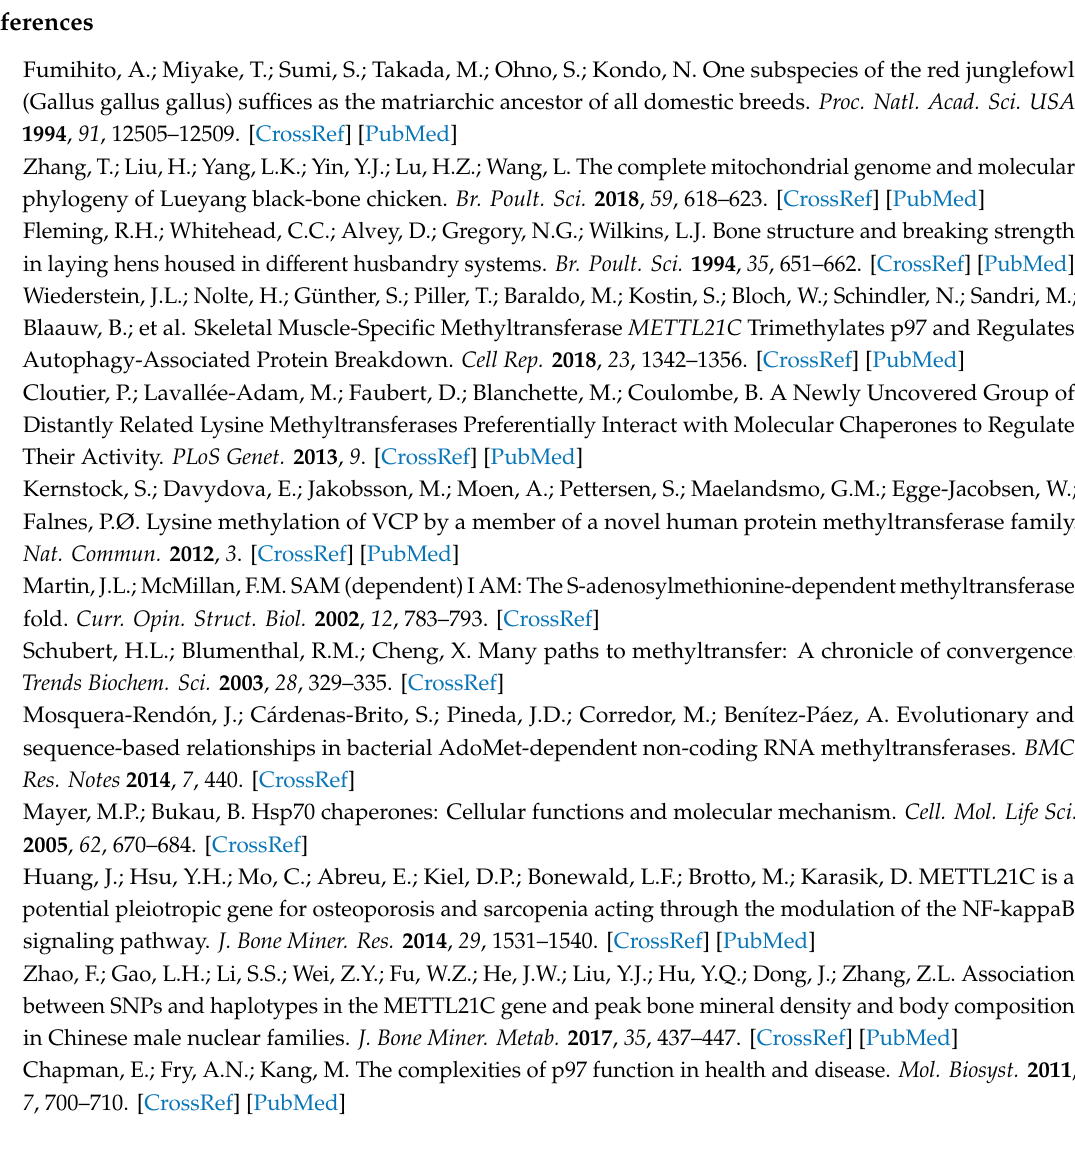
Figure S1: Conserved domain of the METTL21C family identified in 10 chickens ( G. gallus ). Table S1: A total of six samples of chicken muscles used for expression profiling in this study. Table S2: Primer information of qPCR. Table S3: The distribution numbers of METTL21C genes in Groups I–VI. Table S4: Expression data of METTL21C genes in flowers at di ff erent developmental stages of chickens ( G . gallus ). Table S5: Previous names of the METTL21C